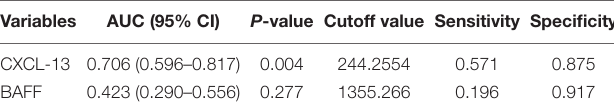
TABLE 4 | Receiver operating characteristic analysis results of different predictors for SCIT efficacy.